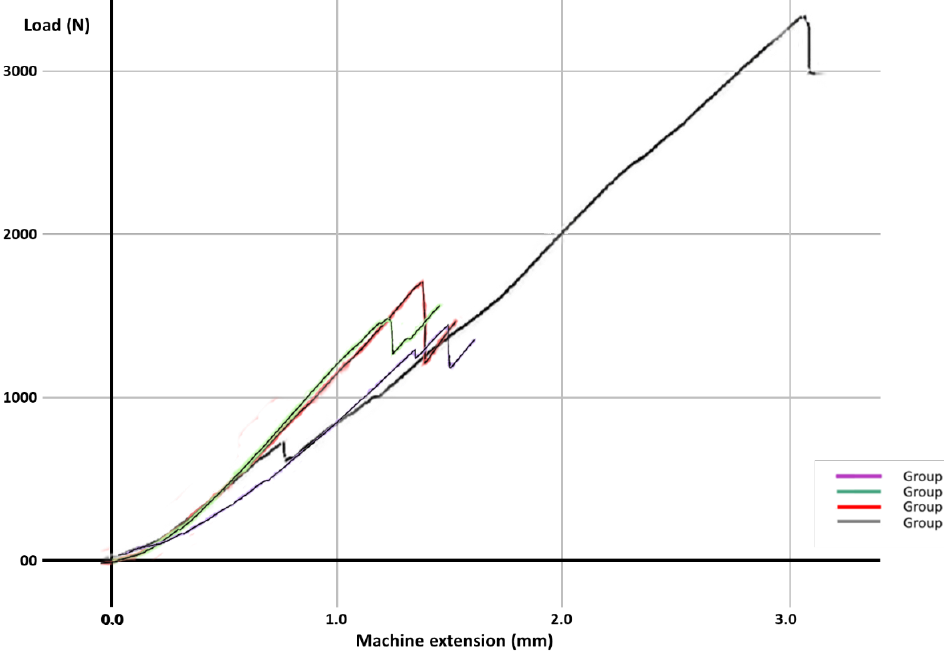
Figure 8. Result comparison for Groups C – F. Table 3. The maximum force values at which the teeth in each of the six groups fractured.